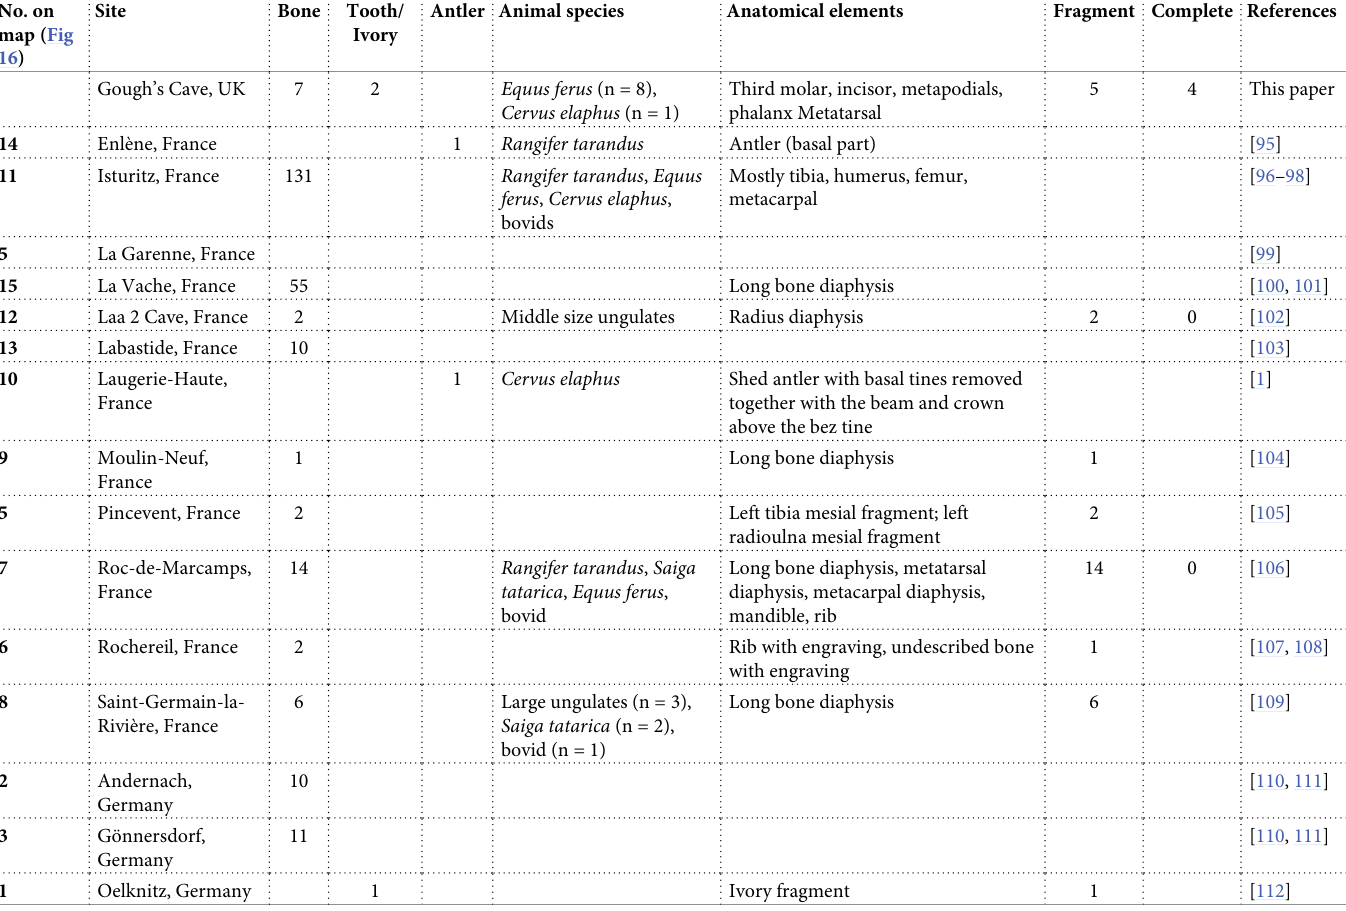
Table 4. Organic knapping tools reported for various Magdalenian bone